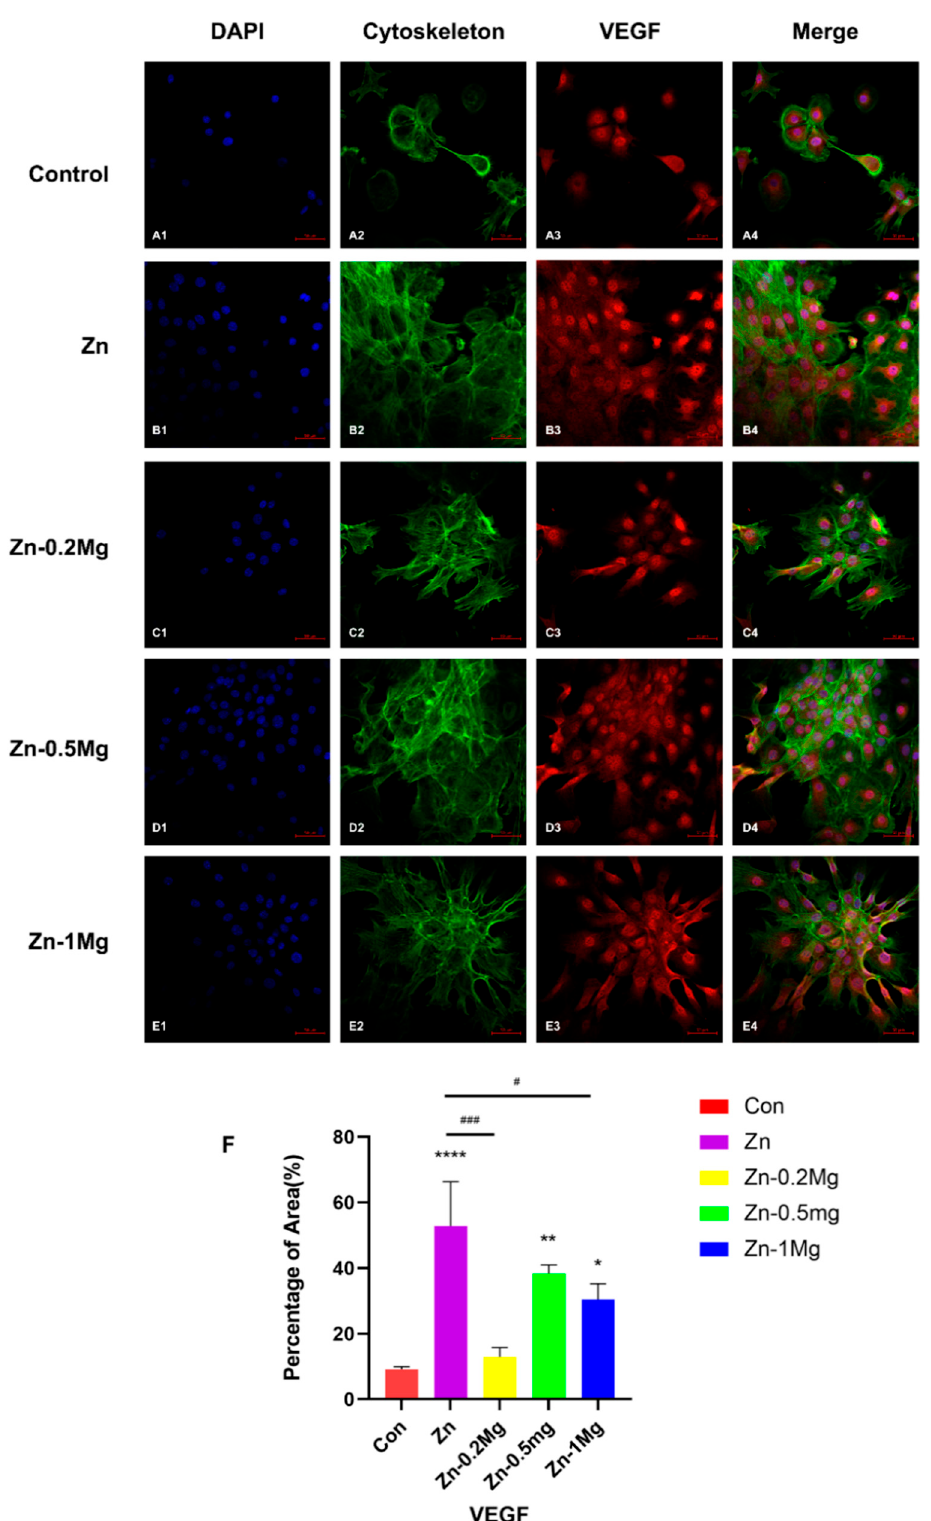
Figure 9. ( A1 – A4 were the control group, B1 – B4 were the Zn group, C1 – C4 were the Zn-0.2Mg group, D1 – D4 were the Zn-0.5Mg group, E1 – E4 were the Zn-1Mg group) Representative immunofluorescence staining images and ( F ) quantitative analysis of VECs. Compared with the control group, **** p < 0.0001, ** p < 0.01, * p < 0.05; compared with Zn group, ### p < 0.001, # p < 0.05.